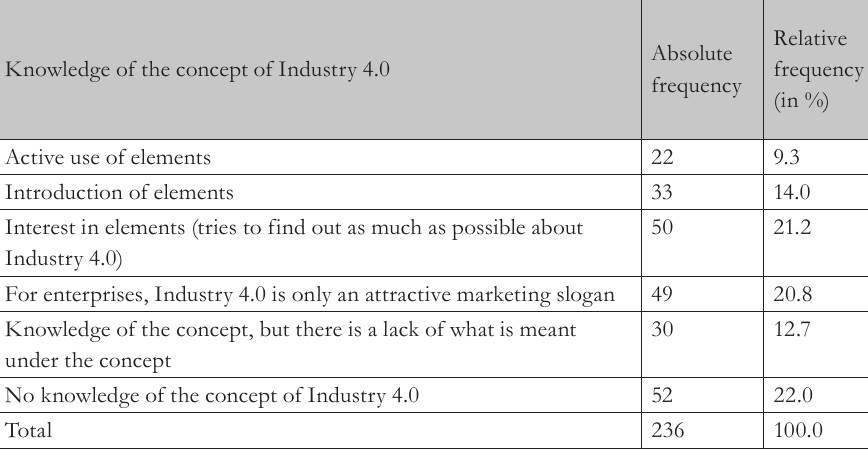
Tab. 4 – Knowledge of the concept of Industry 4.0. Source: Survey